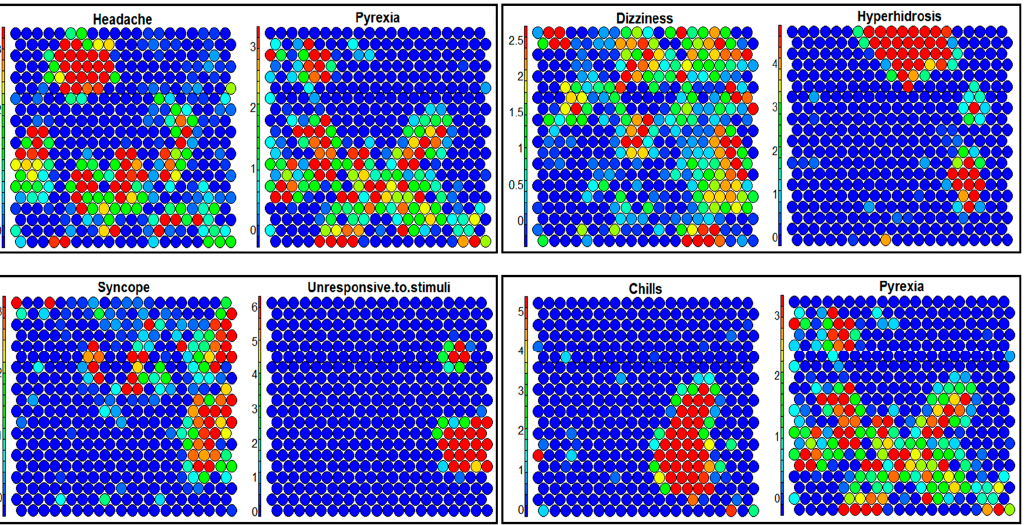
Figure 4. SOM analysis of the top 20 most reported AEs from the reports filtered for children (age 15 (inclusive) and under) for all vaccines. Association of AEs { chills , dizziness , headache , hyperhidrosis , pyrexia , syncope } in the form of 2D cluster similarities is demonstrated as shown in the rules R 4,10,12,14 in Table 3. Table 4. Non-redundant association rules for AEs reported in VAERS reports for the three vaccines.